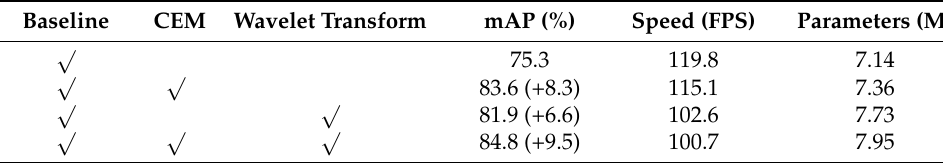
Table 1. Ablation experimental